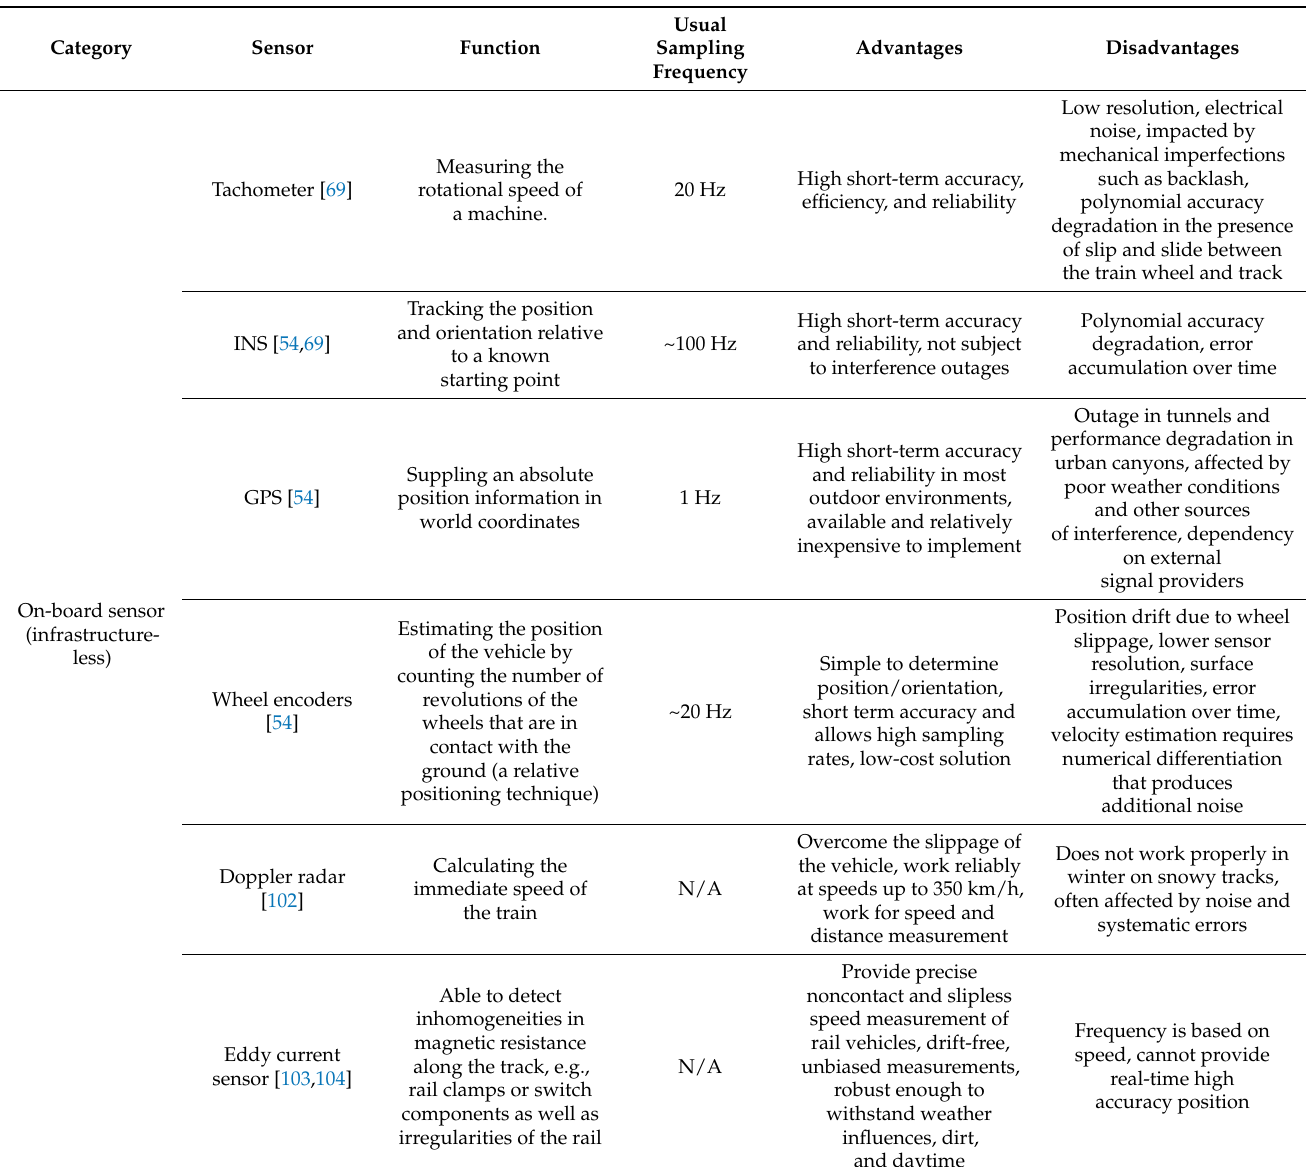
Table 2. Advantages and disadvantages of sensor used in rail